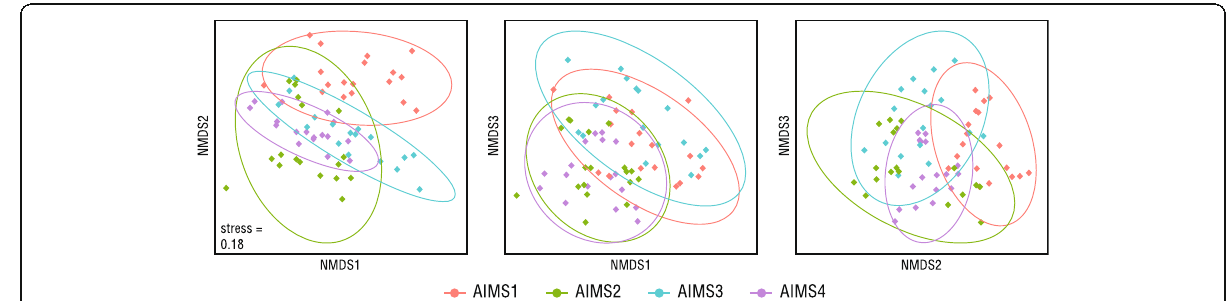
Fig. 4 Comparison of bacterial communities in Ep1 – 4 anemone samples by nMDS on Bray-Curtis distances. All projections of 3D nMDS ordination are shown. Ellipses indicate 95% confidence